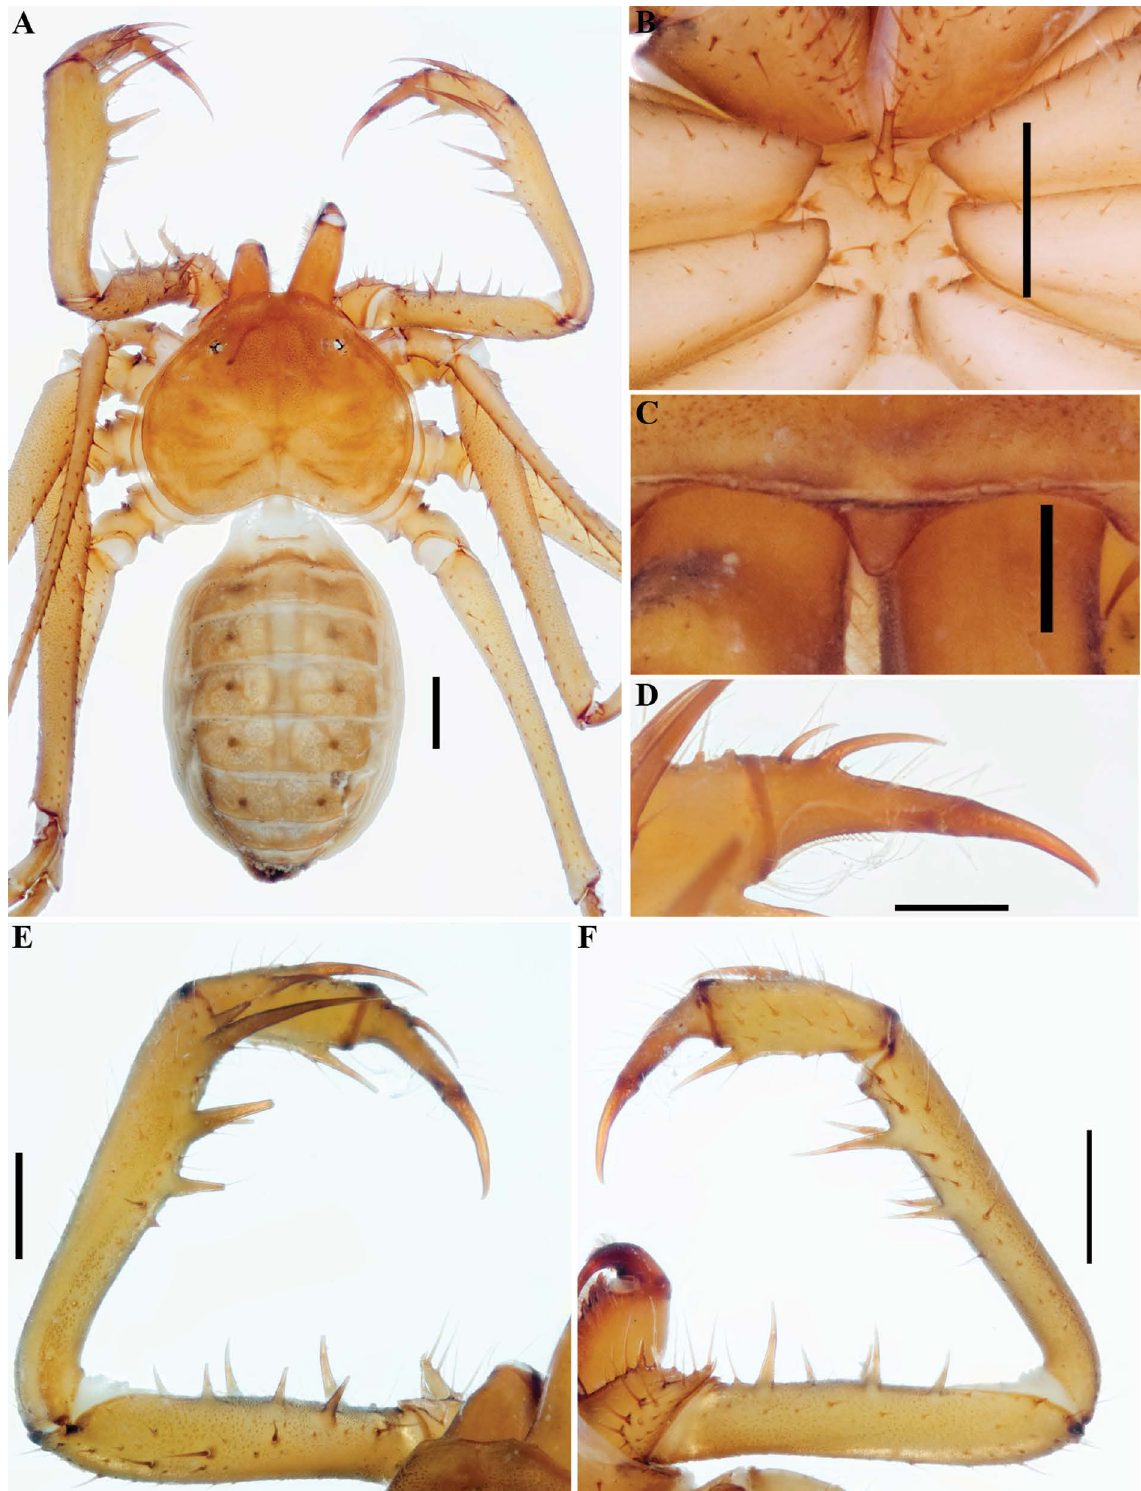
Fig. 42. Charinus mocoa sp. nov. (SMF 68), general morphology, ♀. A . Habitus, dorsal view. B . Sternum, ventral view. C . Frontal process. D . Pedipalp tarsus, frontal view. E . Pedipalp, dorsal view. F . Pedipalp, ventral view. Scale bars: A–B, E–F = 1 mm; C–D = 0.5